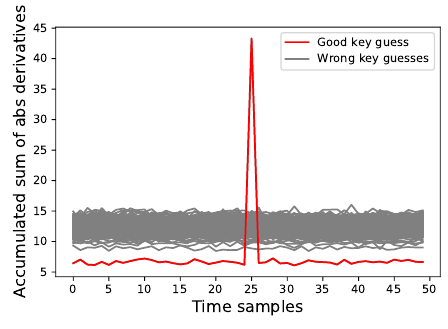
Figure 4: Sum of absolute derivatives accumulated over 250 iterations of SGD (50